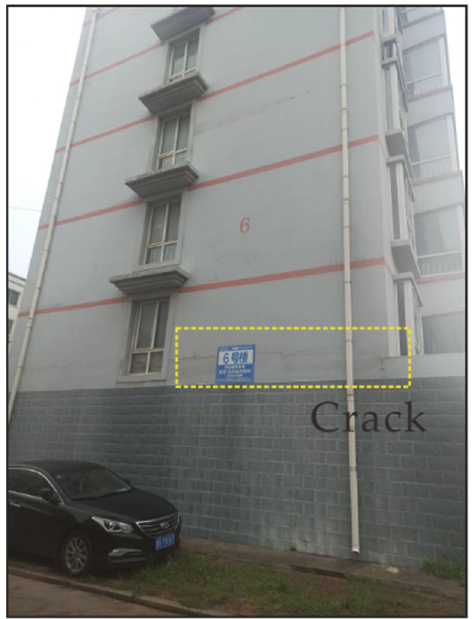
Figure 16. Construction damages due to the mining subsidence (the yellow dashed box shows the position of the cracks).